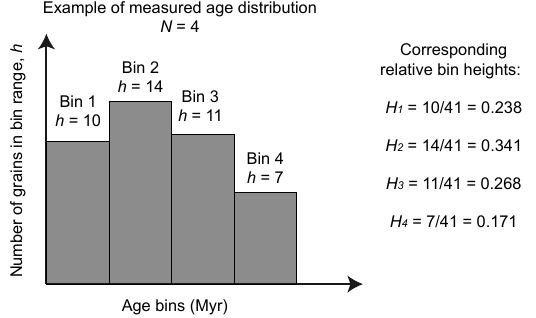
Figure 1. Example of a measured age distribution and the relative heights H k of the corresponding bins ( N = 4 in this example). i